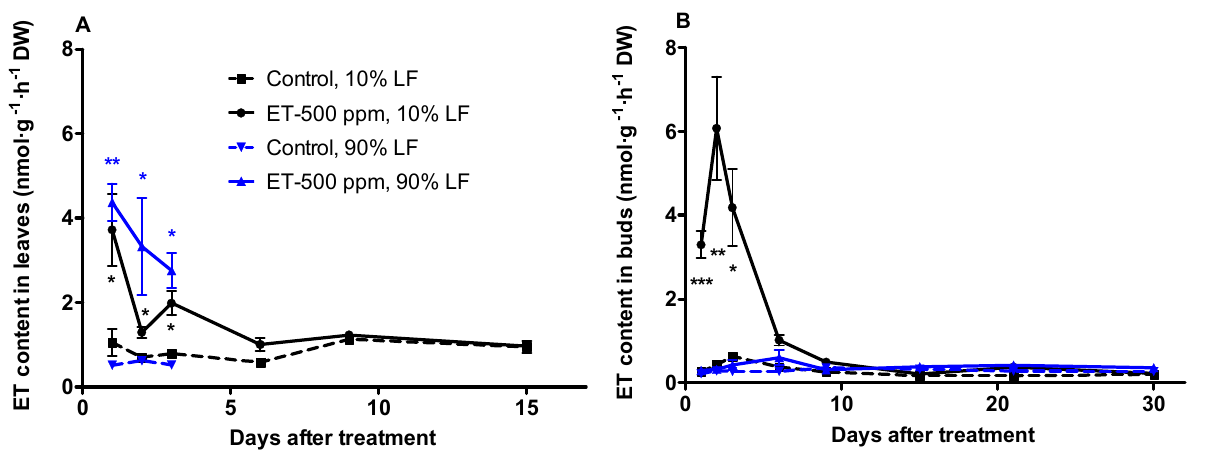
Figure 3. Dynamics of ethylene levels in leaves ( A ) and buds ( B ) of ‘Redhaven’ in response to ethephon application of 500 ppm at 10 and 90% LF. Ethylene levels in leaves were measured until the complete abscission. Each point represents the mean ± SE of size n = 3. Asterisks *, **, and *** indicate significant difference between ET treatments and the control at p < 0.05, 0.01, and 0.001, respectively. ET, ethephon; LF, leaf fall; DW, dry weight.